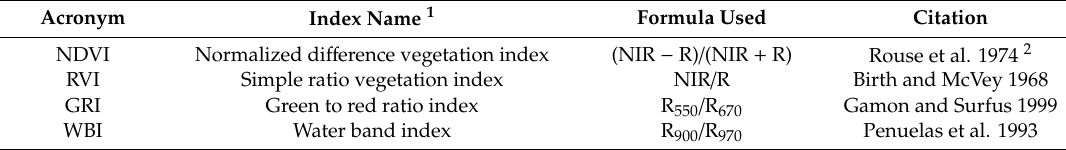
Table 1. Listing of vegetation indices investigated for correlation to tall fescue quality, biomass, tissue N accumulation, and soil volumetric water